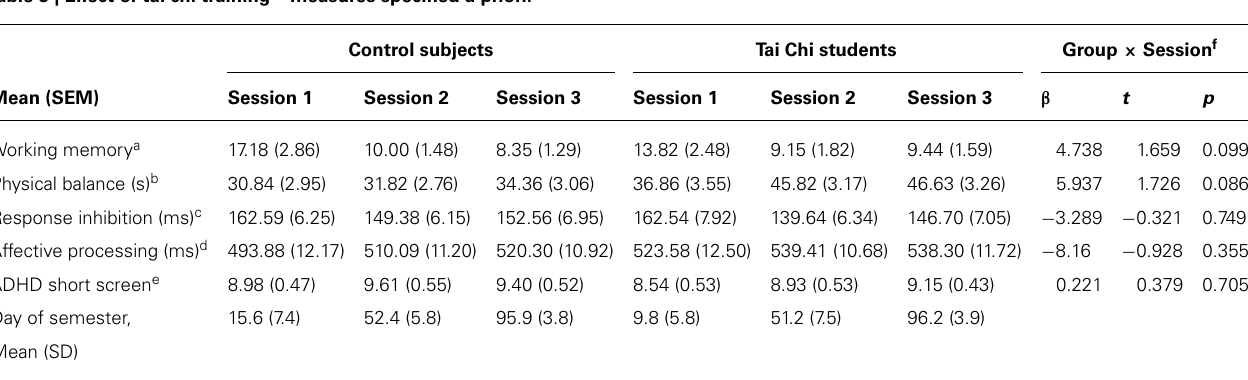
Table 3 | Effect of tai chi training – measures specified a